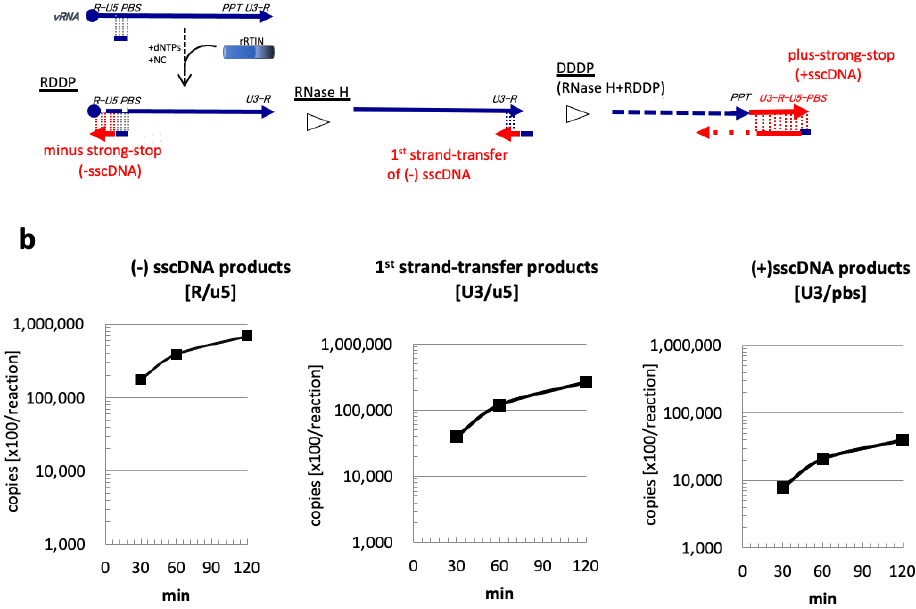
Figure 2. In vitro RT assay using rRTIN. ( a ) rRTIN was subjected to in vitro reverse transcription assay as described previously [22]. cDNAs of minus strong stop (-sscDNA), strand-transfer of - sscDNA (1st strand-transfer) products, and plus strong stop (+sscDNA), generated by RNA-de- pendent DNA polymerase (RDDP), RNase H and DNA-dependent DNA polymerase (DDDP) ac- tivities, are schematically depicted. ( b ). At 30, 60, or 120 min after reaction, the levels of cDNA in- termediates were determined by using the primer set for the R/u5, U3/u5, or U3/pbs region to mon- itor RDDP, RNaseH and DDDP activities. Each value shown is a copy number of a cDNA in 1 μL of the reaction mixture at each time point. 3.3. Impact of IN Fusion on RT Functions We directly compared RT activities of rRTIN and rRT in modified assay conditions in which the amounts of the reaction substrates were varied to address differences be- tween these proteins in detail. As the critical role of IN during HIV-1 virion morphogen- esis through interaction with vRNA has been reported [15 – 17], we first compared - sscDNA (R/u5) levels generated by rRTIN or rRT under different concentrations of syn- thetic vRNA [22] (Figure 3a). In this experiment, the velocity of -sscDNA synthesis during 60 min of the reaction was measured; data are shown as values relative to the velocity at 100 ng vRNA as 1.0. From the velocity plot results, we estimated the affinity of rRTIN or rRT for vRNA (Km for vRNA) by calculating the vRNA concentration to give a relative velocity of 0.5. The estimated Km value for vRNA was not significantly different between rRTIN and rRT (Figure 3b). We also found that rRTIN possessed the first strand-transfer (Figure 3c) and +sscDNA synthesis (Figure 3d) efficiencies equivalent to those of rRT. These results demonstrated that rRTIN possessed RDDP, RNase H and DDDP activities that were almost equivalent to those of RTp66 under these experimental conditions.